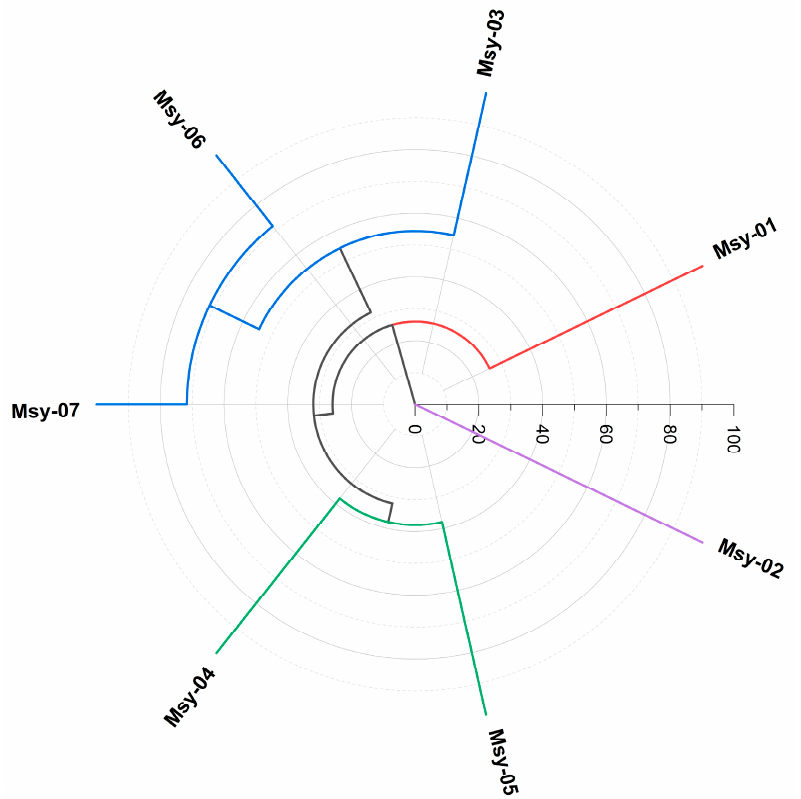
Figure 2. Dendrogram representing the similarity relation of the oil composition of Myrcia sylvatica . The Principal Components Analysis elucidated 81.5% of the data variability. PC1 ex- plained 42.3% and showed positive correlations with the constituents spathulenol (r = 0.22), caryophyllene oxide (r = 0.33), viridiflorol (r = 0.29), muurola-4,10(14)-dien-1 β -ol (r = 0.36), epi - α -murrolol (r = 0.34), and α -cadinol (r = 0.36). The second component explained 22.3% and presented a positive correlation with the compounds β -caryophyllene (r = 0.07), germa- crene D (r = 0.43), δ -cadinene (r = 0.48), caryophyllene oxide (r = 0.05), viridiflorol (r = 0.08), α -cadinol (r = 0.19), and epi - α -cadinol (r = 0.47). The third component, PC3, explained 17.0% of the data and explained a positive correlation with the variables β -caryophyllene (r =